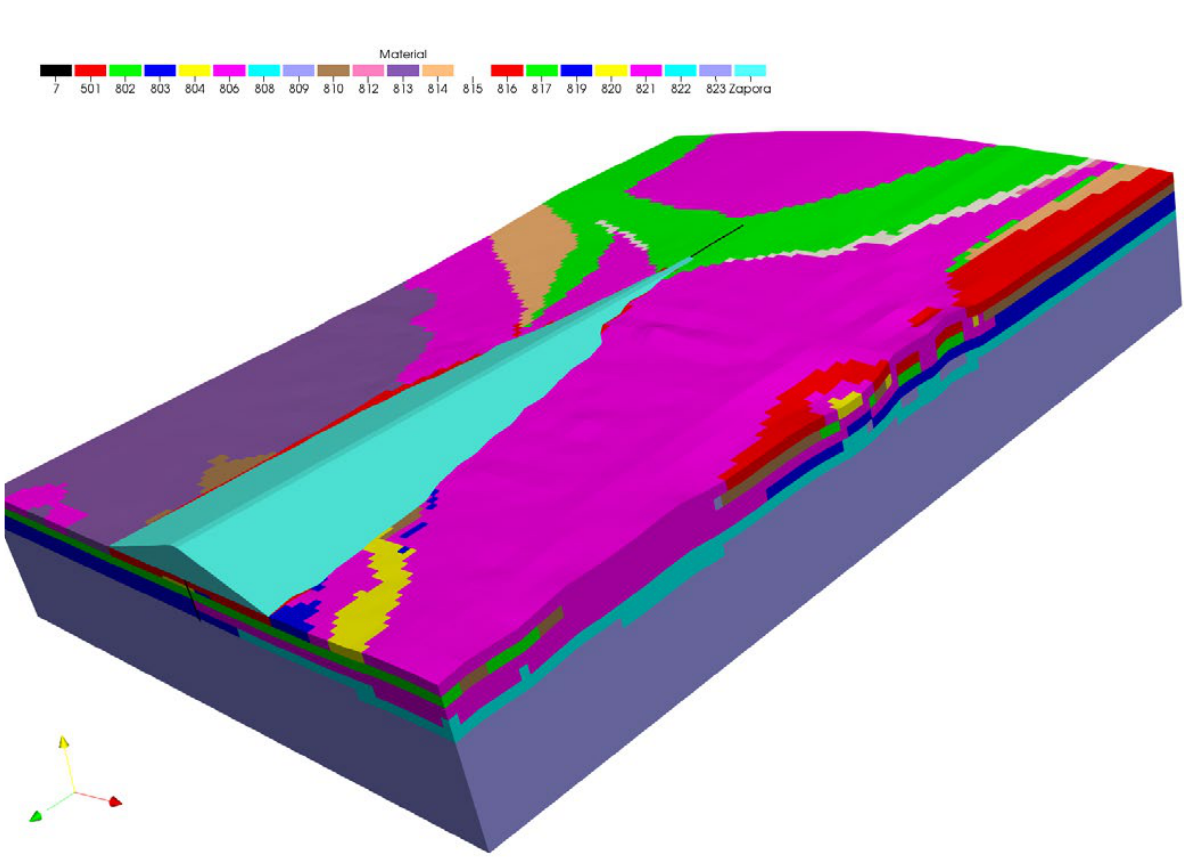
Figure 7: Model of the subsoil with the distribution of geotechnical layers within the western abutment